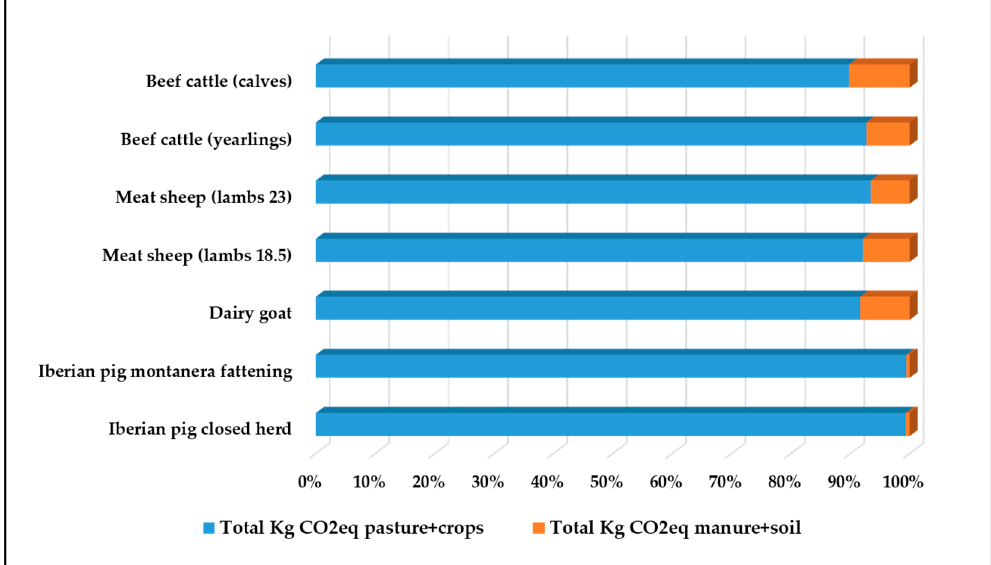
Figure 2. Percentage of carbon in the soil deriving from the vegetable waste and from manure and dung depositing.